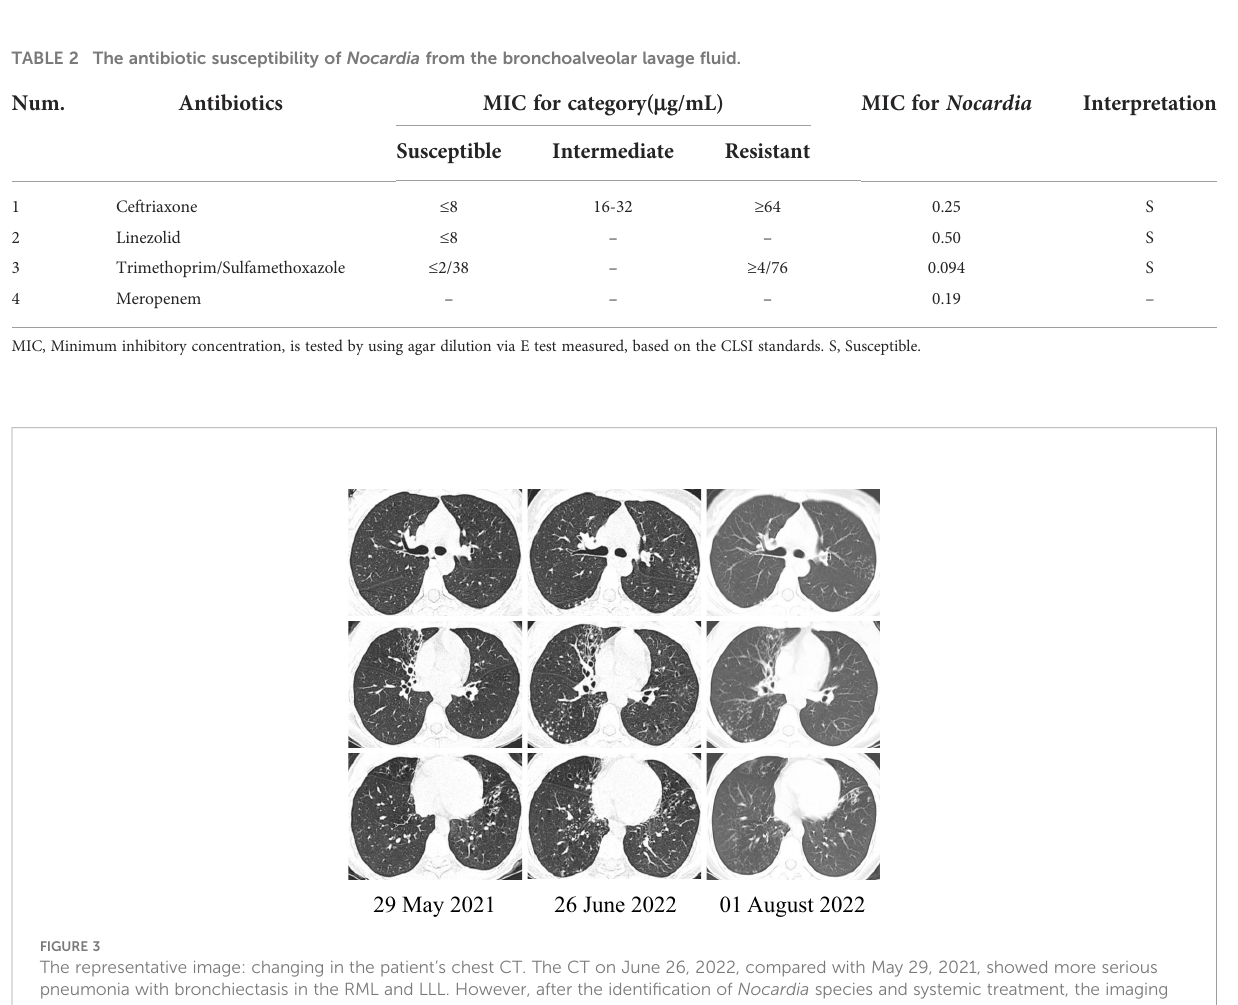
Figure 4. The sequences identi fi ed by the whole genome were 54,536. The phylogenetic trees were constructed based on the sequences of 16S rRNA gene and housekeeping genes and are shown as Figure 5.